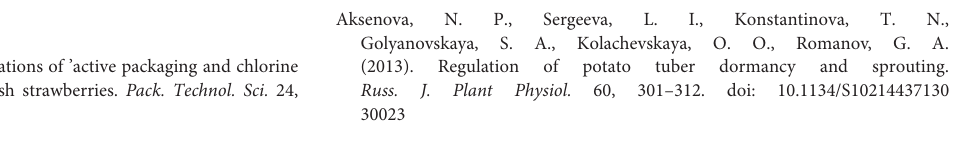
Supplementary Figure 1 | Verification of some gene expression related to phenylpropane biosynthesis (A) and plant hormone signal transduction (B) . Bars indicate standard error ( ± SE). Asterisks indicate a significant difference ( p < 0.05). Supplementary Figure 2 | The network regulation map between different genes and different metabolites. Supplementary Table 1 | Gene primer sequence of genes related to the synthesis of suberin and lignin. Supplementary Table 2 | Statistical sequencing data. Supplementary Table 3 | Statistical comparison efficiency of each